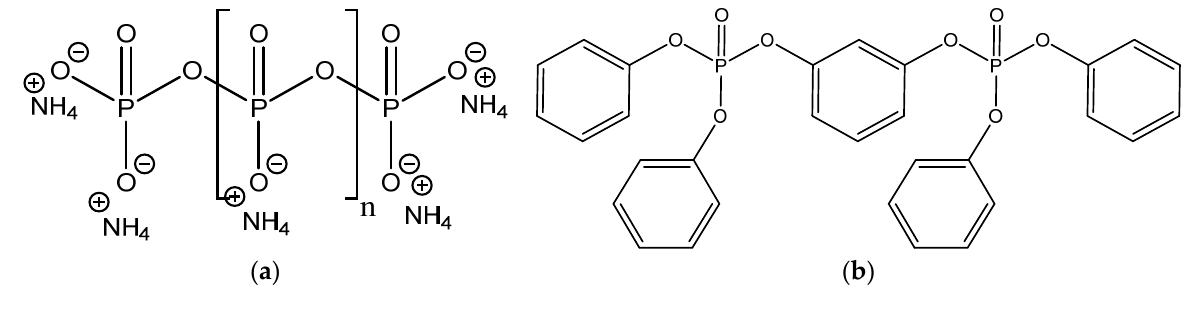
Figure 1. The chemical structure of APP ( a ) and RDP ( b ).